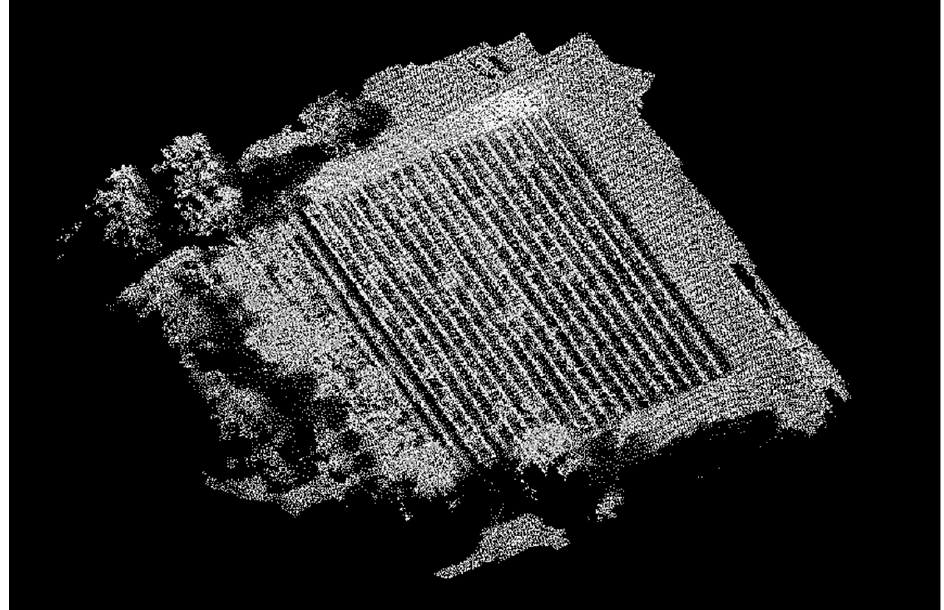
Figure 4. Dense cloud relative to the RED W band in grey-level visualisation. After generating six dense clouds, one for each set of images, they were imported in CloudCompare, an Open-source tool for the point cloud and mesh processing first developed by Daniel Girardeau-Montaut [58,59]. Finally, using the “rasterize” tool in Cloud Compare, which allows for transforming a point cloud into a 2.5D grid by setting (DSM) were generated with a pixel size of 3